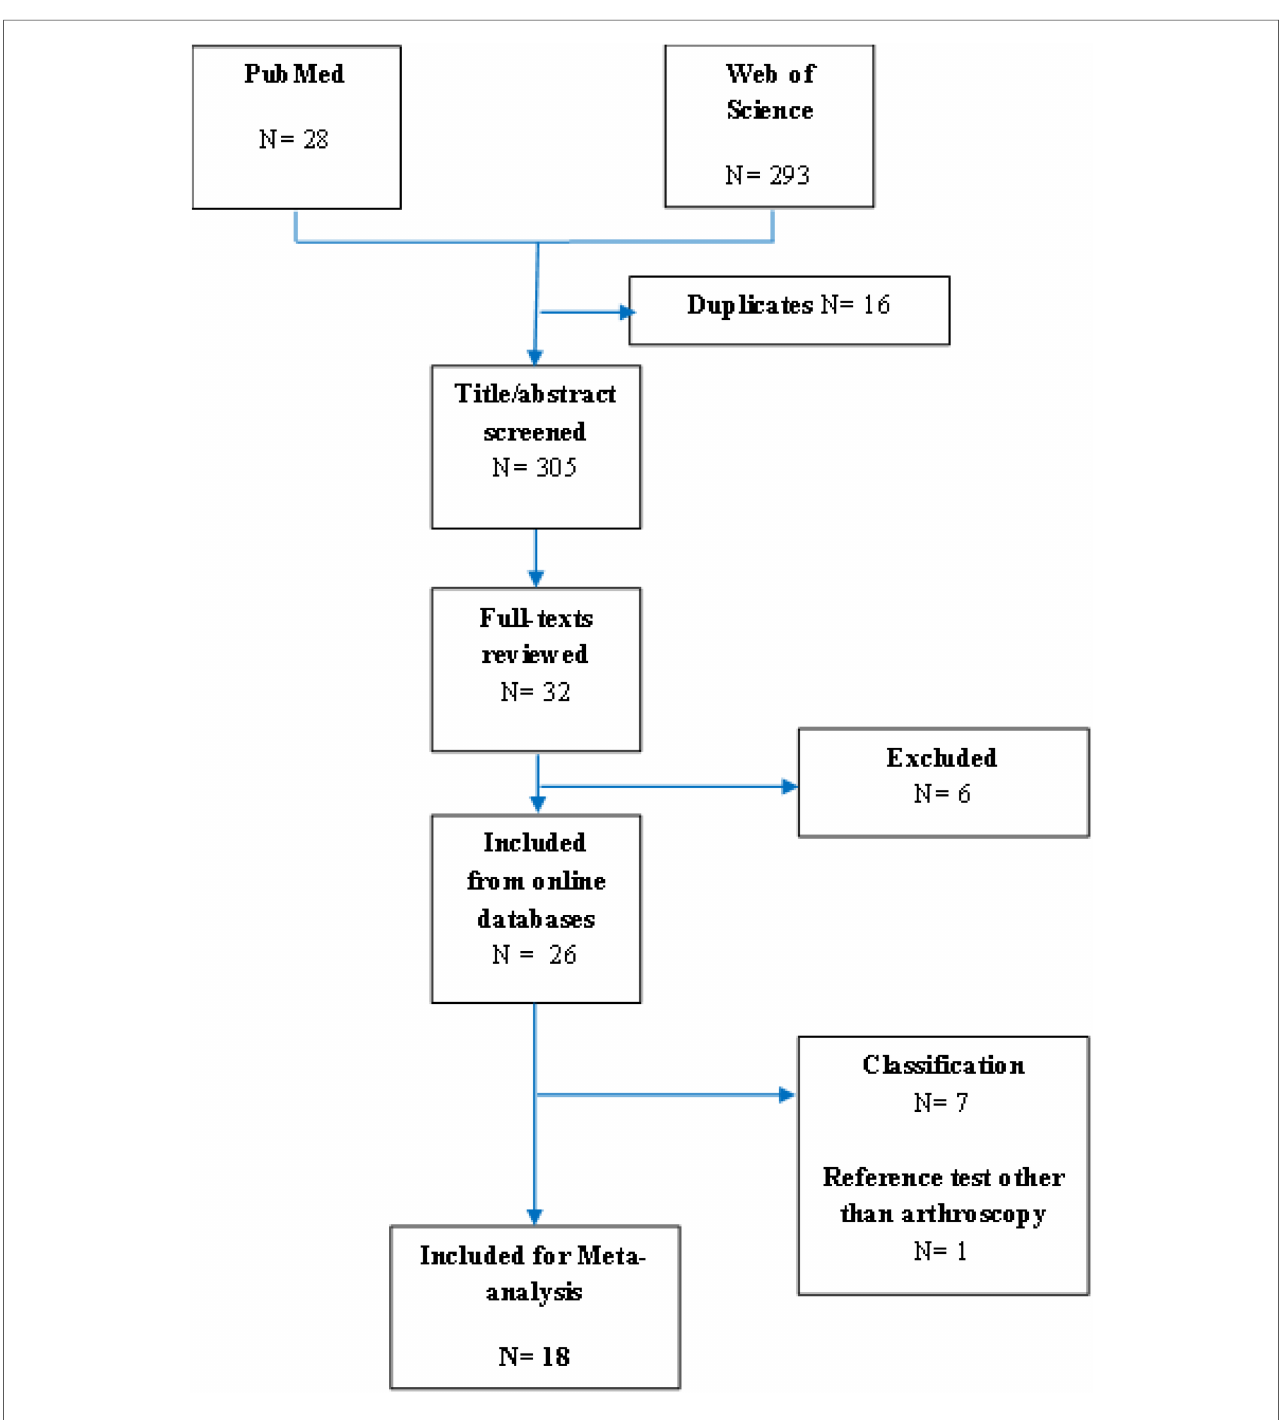
FIGURE 1 Flow diagram of the selection